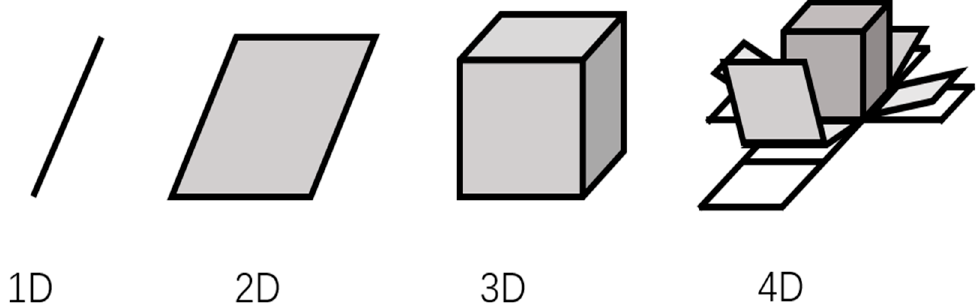
Figure 16. Of 1-, 2-, 3-, and 4D concepts. A 4D structure is a structure (x, y, z) made by 3D changes over time (t). Arrows indicate the direction of change with respect to time.